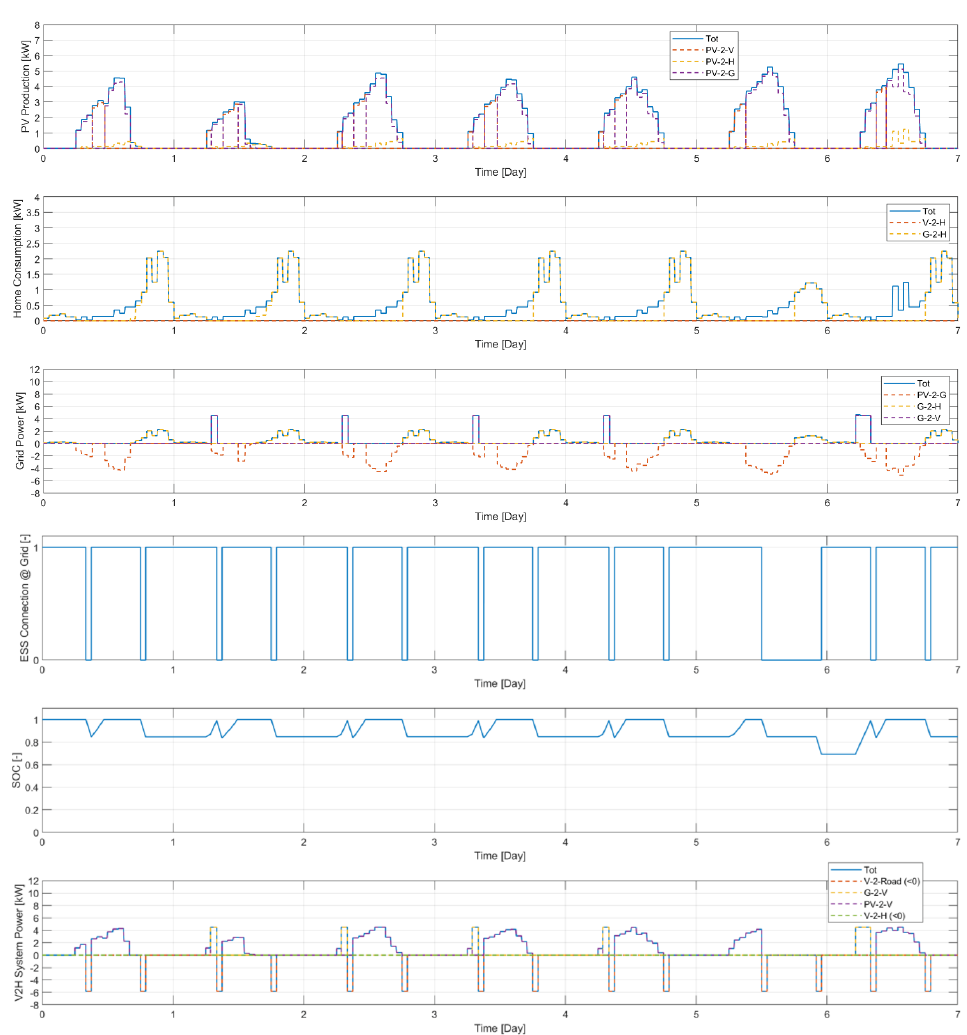
Figure 17. Summer week. Case2A — SW 1D results.